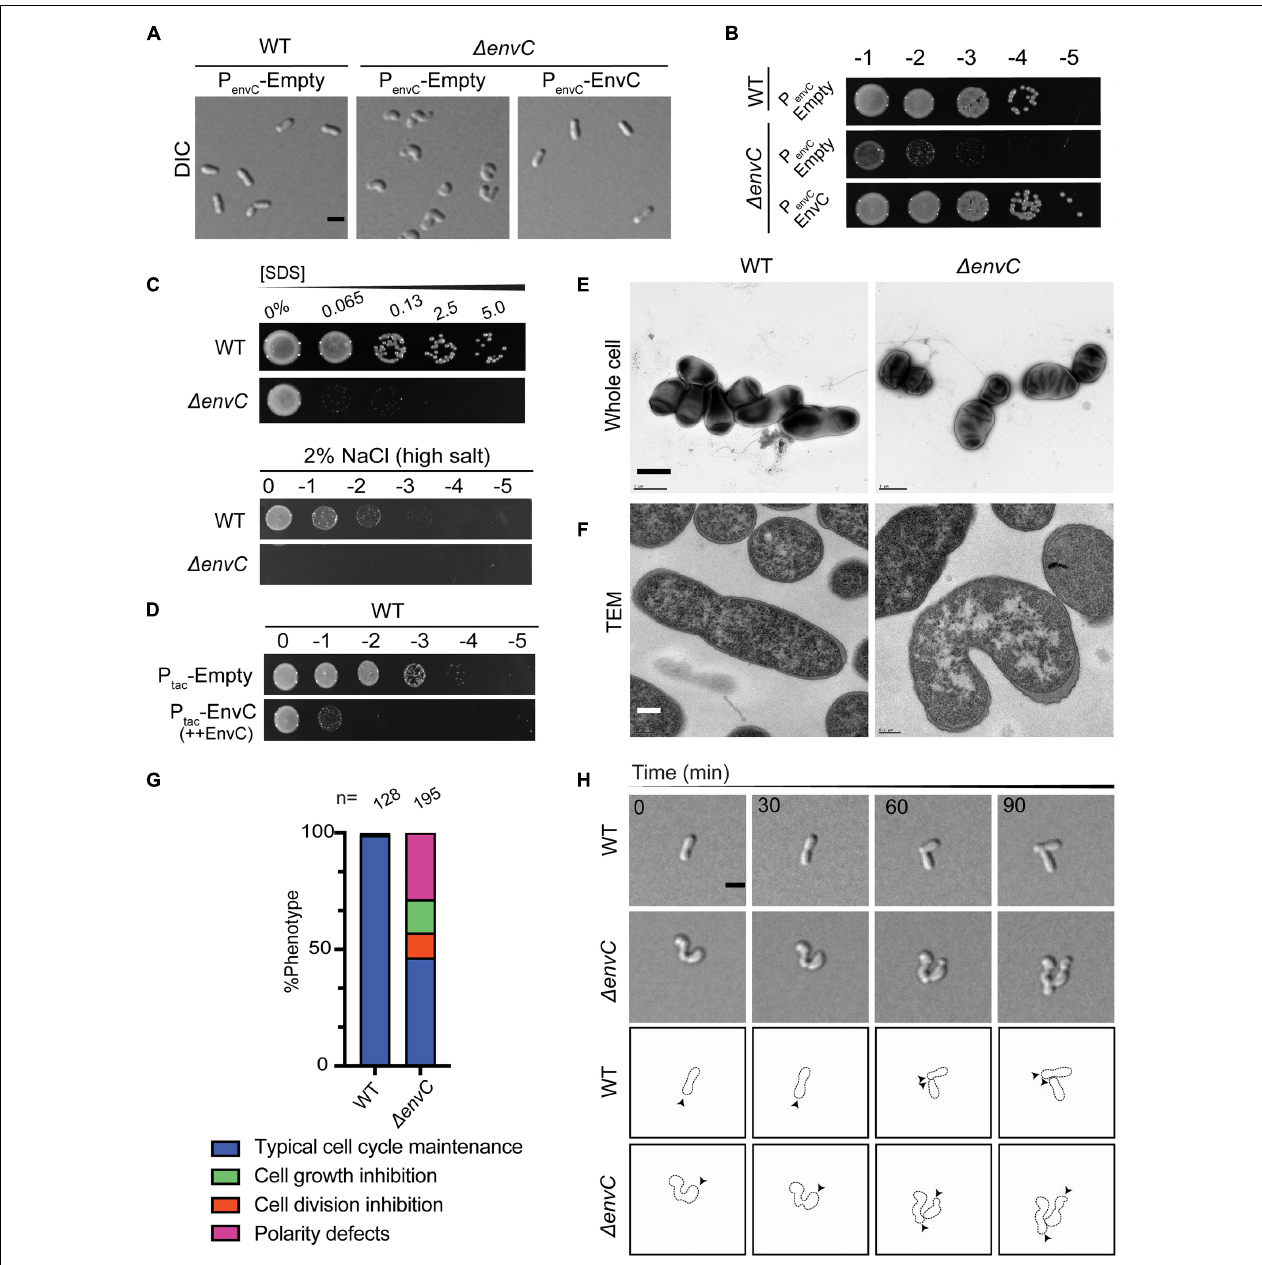
FIGURE 3 | Loss of envC results in cell curvature, decreased viability, and OM destabilization in A. tumefaciens . (A) DIC images of exponentially growing WT cells containing empty plasmid (PenvC-Empty), (cid:49) envC containing empty plasmid (PenvC-Empty), or (cid:49) envC expressing envC via its native promoter [PenvC-EnvC (complementing plasmid)]. (B) Cell viability of WT cells expressing empty plasmid (PenvC-Empty), (cid:49) envC containing empty plasmid (PenvC-Empty), or (cid:49) envC expressing envC via its native promoter [PenvC-EnvC (complementing plasmid)] is shown by spotting serial dilutions. (C) SDS and salt sensitivity of WT and (cid:49) envC . Briefly, for the SDS assay, exponentially growing cells were treated with various concentrations of SDS for 5 min and spotted on LB plates and analyzed 24 h post incubation. To assess salt sensitivity, exponentially growing WT and (cid:49) envC were serially diluted and spotted on LB solid medium containing 2% NaCl (high salt) and analyzed ∼ 36 h post incubation. (D) Cell viability of WT strain after overexpression of empty plasmid (Ptac-Empty) or envC under the control of the tac promoter (Ptac–EnvC). (E) TEM of whole cells of WT (left) A. tumefaciens or the (cid:49) envC mutant (right). Cells were grown ∼ 16 h in LB to early stationary phase, fixed, and stained with 2% uranyl acetate. Scale bar = 1 µ m. (F) Thin section TEM of WT (left) A. tumefaciens or the (cid:49) envC mutant (right). Cells from (E) were embedded in resin and prepared as described in the methods. Scale bar = 0.2 µ m. (G) Quantitative analysis of the phenotypes of the WT and (cid:49) envC strains. % Phenotype was calculated by counting the number of cells in a WT and (cid:49) envC time-lapses displaying one of the phenotypes indicated and dividing it by the total number of cells per strain. ( H , top) Time-lapse microscopy of WT and (cid:49) envC over the course of 90 min. Scale bar = 2 µ m. ( H , bottom) Schematic of WT and (cid:49) envC time-lapses. Arrows indicate active growth. All data collected for this figure was obtained from cells grown in